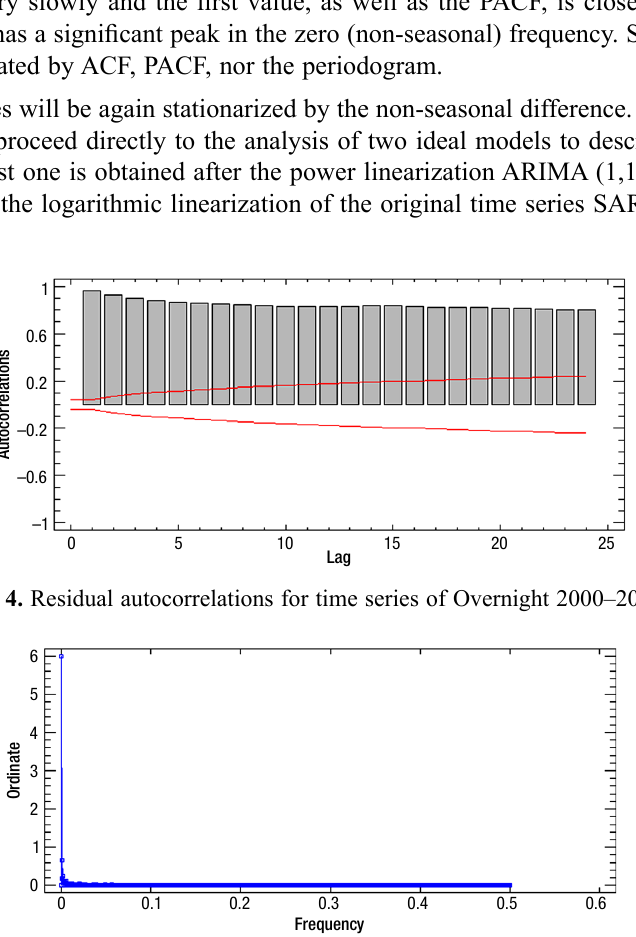
Fig. 5. Residual periodogram for time series of Overnight